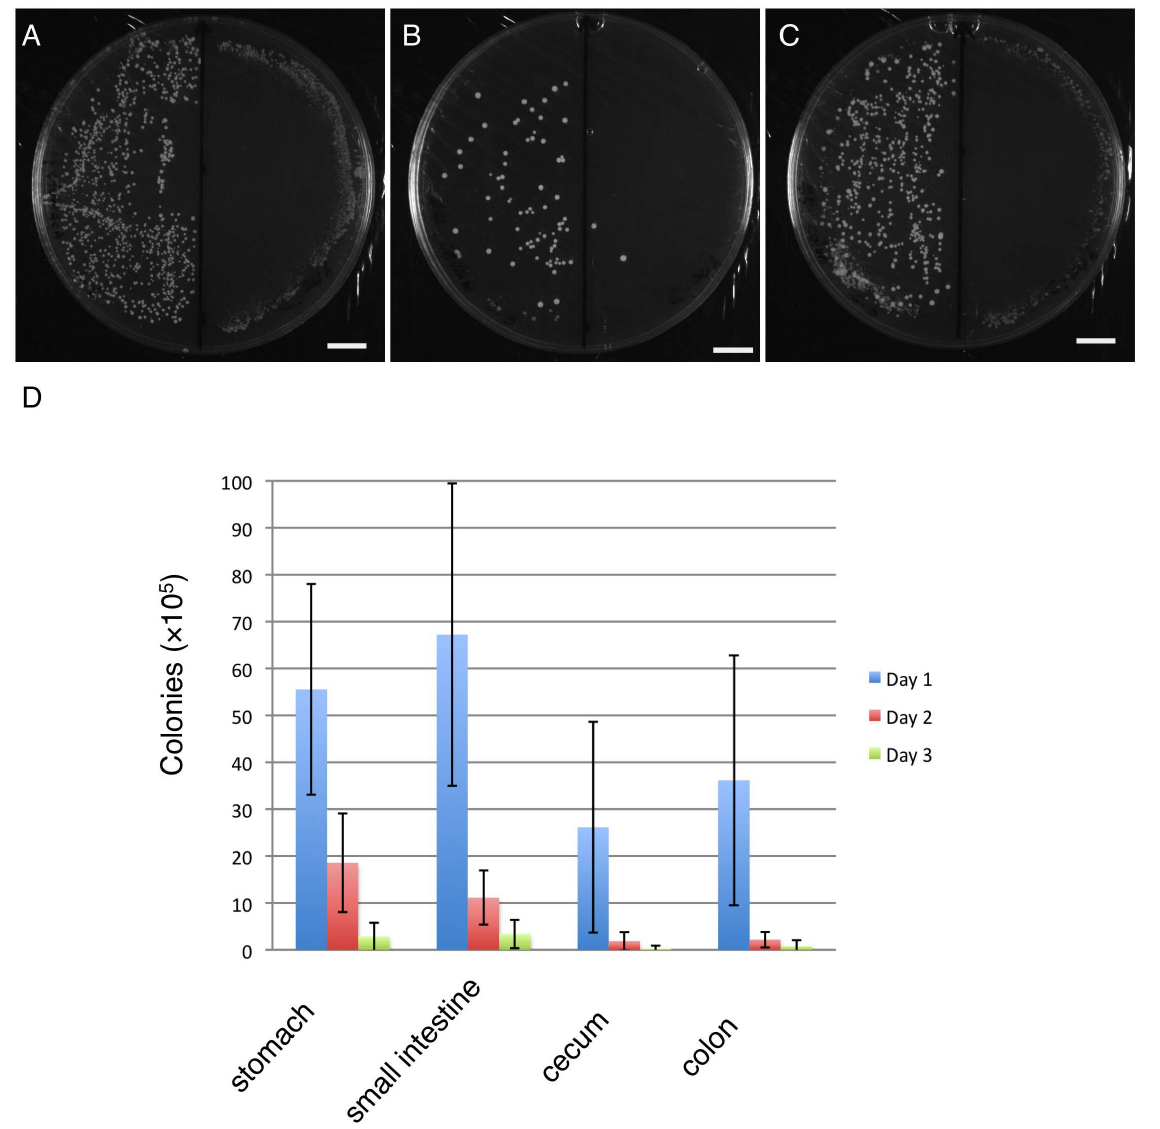
Figure 4. Dynamic distribution of Lactobacillus in the GI tract of neonatal rats. Neonatal rats were fed with L. casei expressing mRFP1. Animals were sacrificed on Days 1, 2, 3 and 4 after gavage. The gastrointestinal homogenates were diluted and plated on MRS plate in the presence of erythromycin. Control rats were fed with saline only. Homogenates from experimental groups were plated on the left half of each plate and those from controls on the right half (A–C). Colonies were found in animals fed with labeled bacteria on Day 1. A) Stomach; B) cecum; C) colon. Scale bars, 10 mm. D) Entire colony counts. Samples were collected on Days 1 (blue), 2 (red) and 3 (green). Note: standard deviation was used to measure